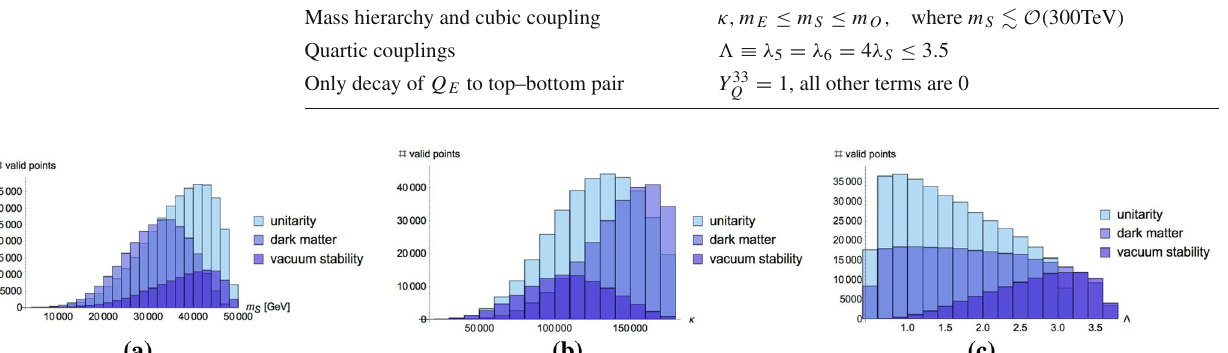
Fig. 2 Left: distribution of m S after various cuts. Middle: the same for κ . Right: the same for (cid:8) . One can see that the cutoff at (cid:8) ∼ π is due to unitarity. The y-axis shows, in all three plots, how many of one million